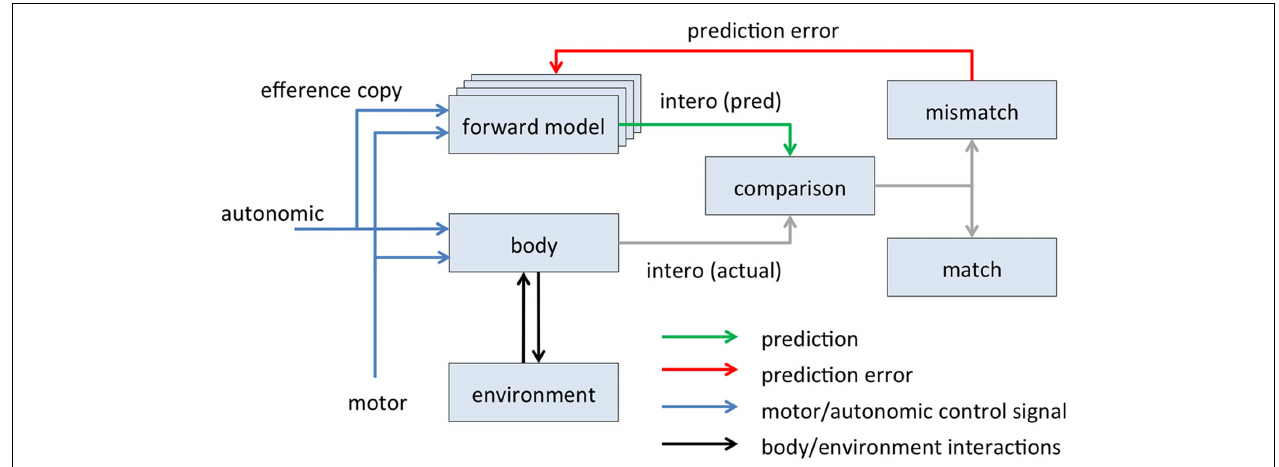
forward/generative models informed by motor and autonomic efference copy signals.The comparison, which may take place in AIC, generates a prediction error which refines the generative models. Subjective feeling states are associated with predicted interoceptive signals intero(pred).The figure is adapted from a general schematic of predictive coding in (Bubic et al.,